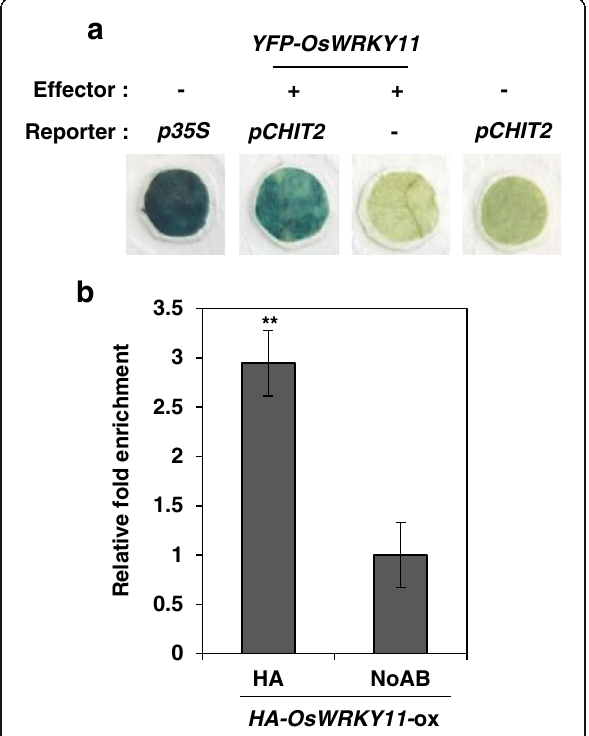
Fig. 4 Os WRKY11 directly binds to and activates the CHITINASE 2 promoter. a Nicotiana benthamiana leaf discs were infiltrated with Agrobacterium carrying pCHIT2::GFP-GUS alone or with a mixture of Agrobacterium carrying 35S::OsWRKY11 and pCHIT2::GFP-GUS . Promoter activities in each sample were visualized 2 days post-infiltration using β -glucuronidase (GUS) activity staining. b Transgenic rice leaves expressing 35S :: HA - OsWRKY11 were used for chromatin immunoprecipitation with anti-HA antibody.